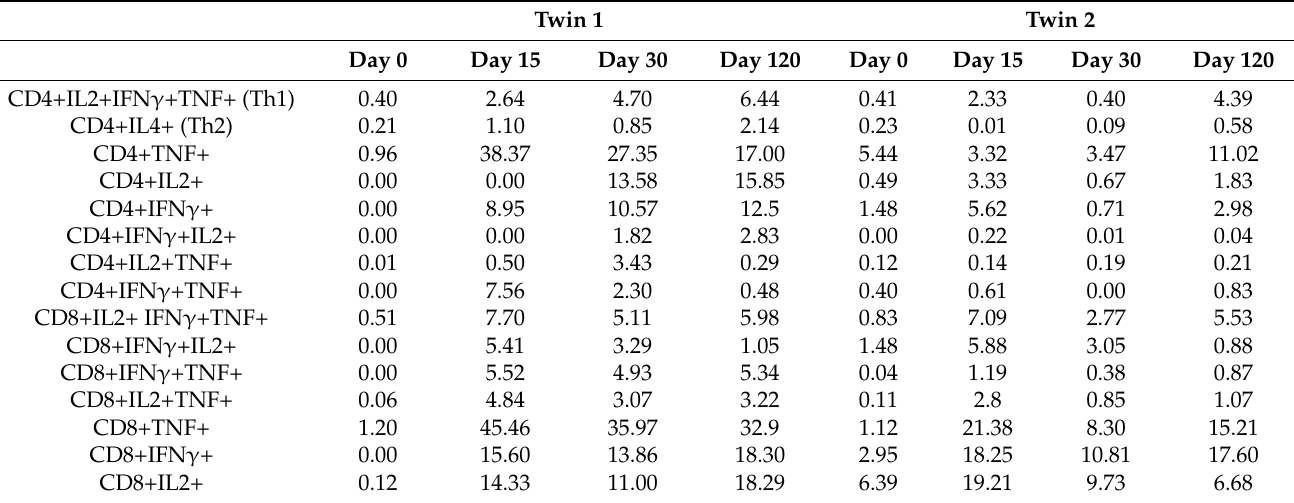
Table 2. Percentages (%) of activated T lymphocytes subsets (CD3+CD38+) producing cytokines after stimulation with spike